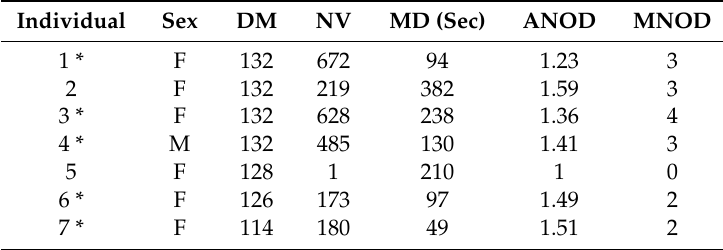
Table 1. Summary of the visits to feeding sites by individuals. Days of monitoring (DM), number of visits (NV), mean duration (MD), average (ANOD), and maximum number (MNOD) of other roe deer detected during the visits, are shown for each of the seven marked roe deer. Legend: Sex = F (female), M (male). * = animal equipped with GPS